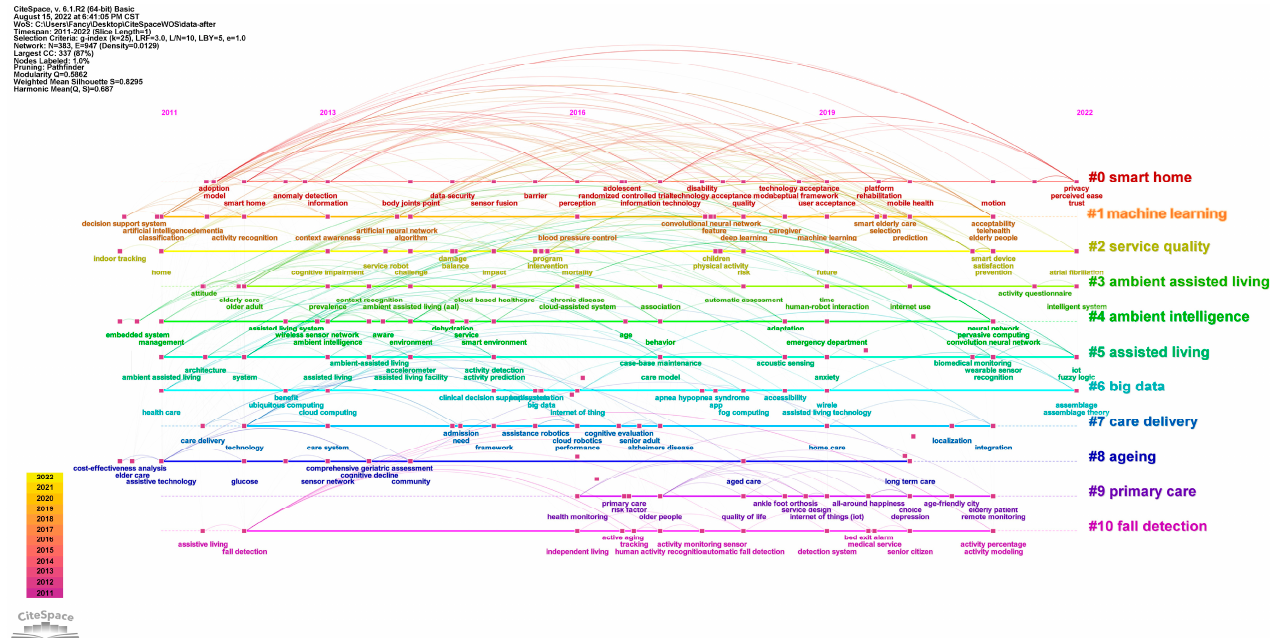
Figure 10. The research timeline of smart elderly care from WOS. Note: These figures were gener ‐ ated using the CiteSpace Software. Due to the size of the figure and page layout, the image may not be clear. For access to the high ‐ quality version of these figures, please visit the following website: https://figshare.com/articles/figure/The_research_timeline_of_smart_elderly_care_WOS_and_CN KI_/21800783. (accessed on 25 December 2022).